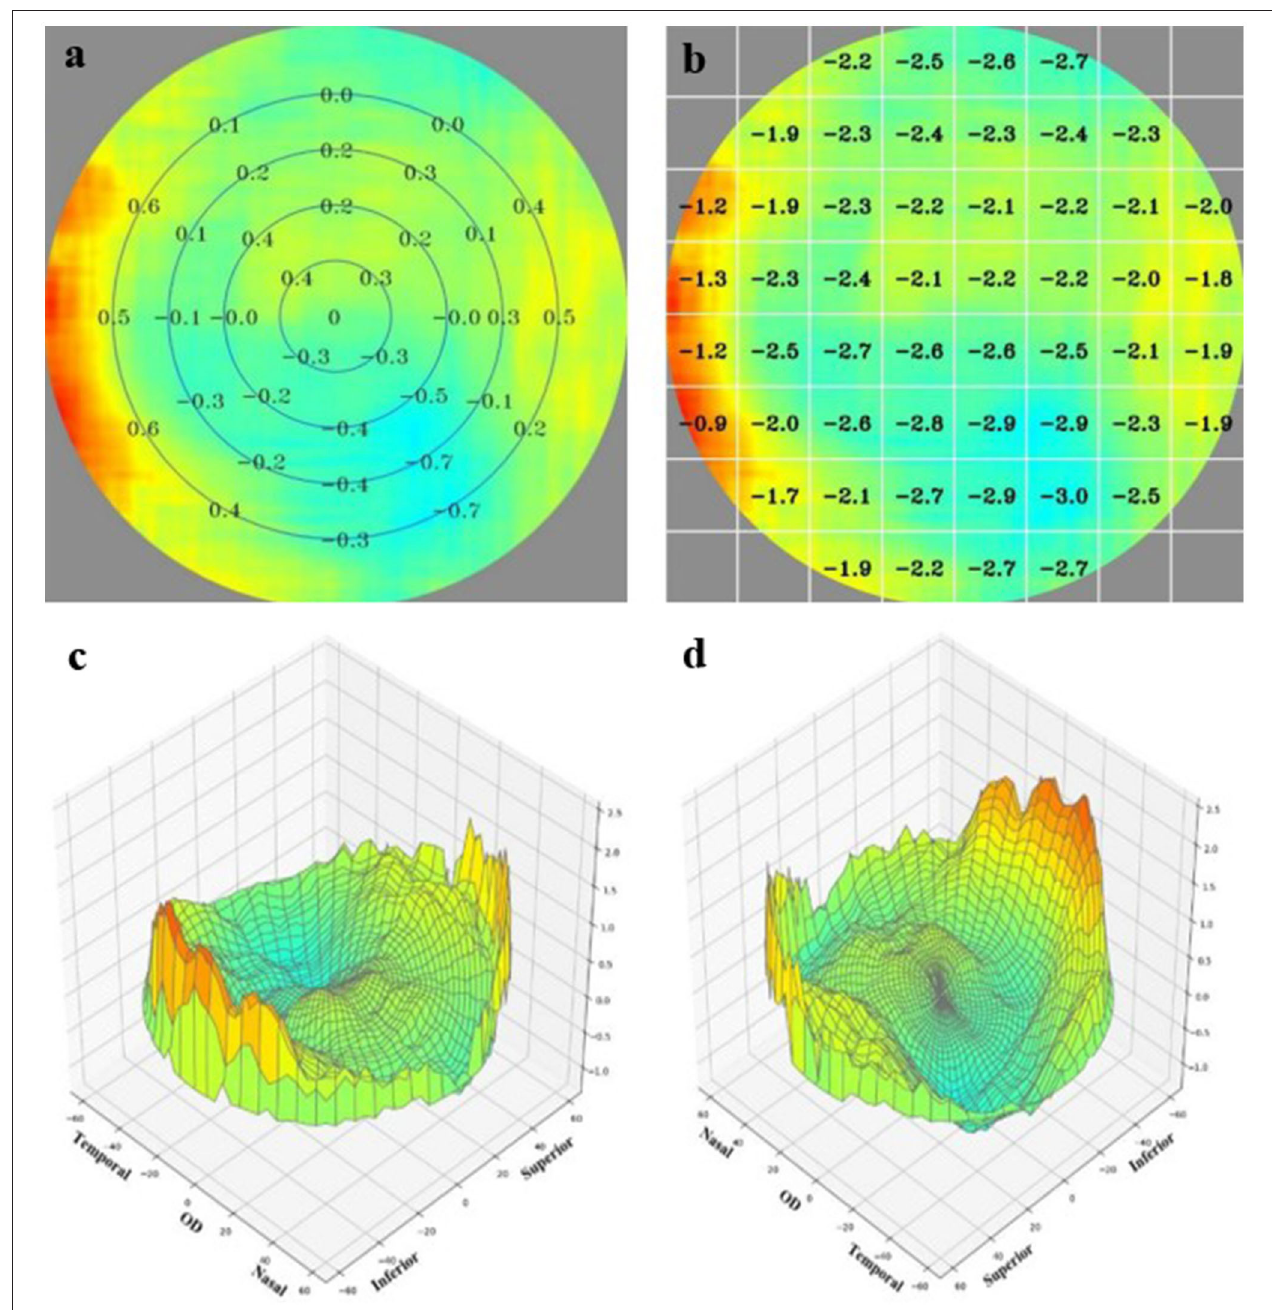
compensation software was obtained using the color-coded approach ( Figure 2 ). Relative peripheral refraction defocus was the difference between the absolute refraction and the central macular refraction and was translated into color images ( Figure 2a ). Block-refraction provided an absolute refraction value using each value as mean data for each